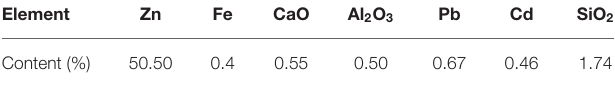
TABLE 1 | Chemical composition of pure smithsonite samples.